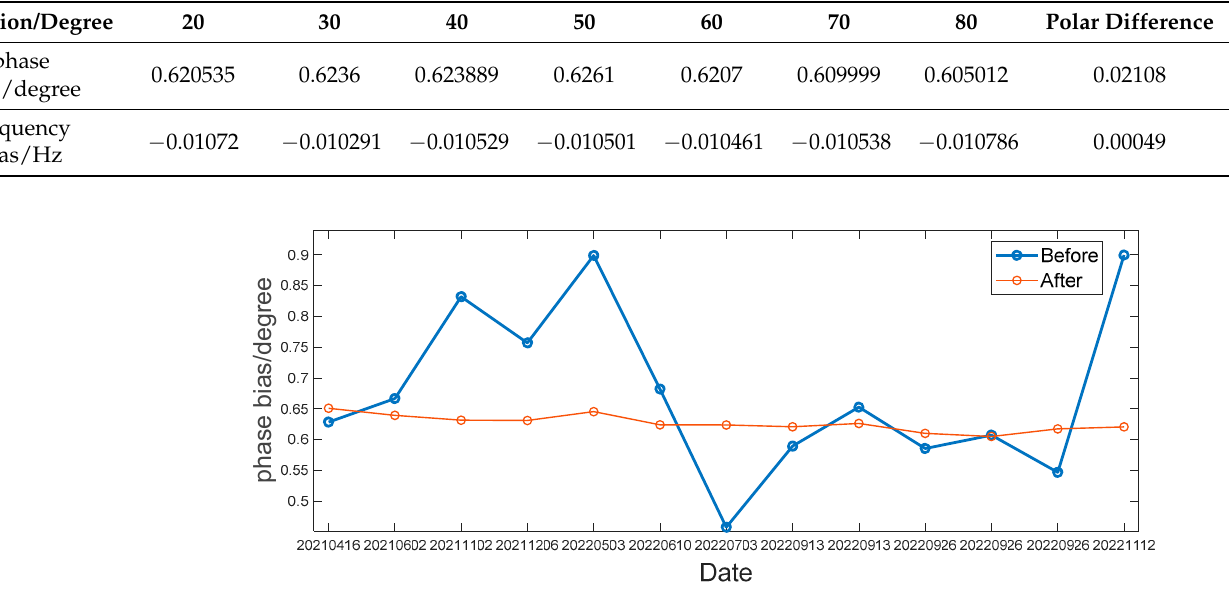
Figure 11. Carrier phase bias estimation between B2ad and B2ap of BDS3 prn 21 satellite.